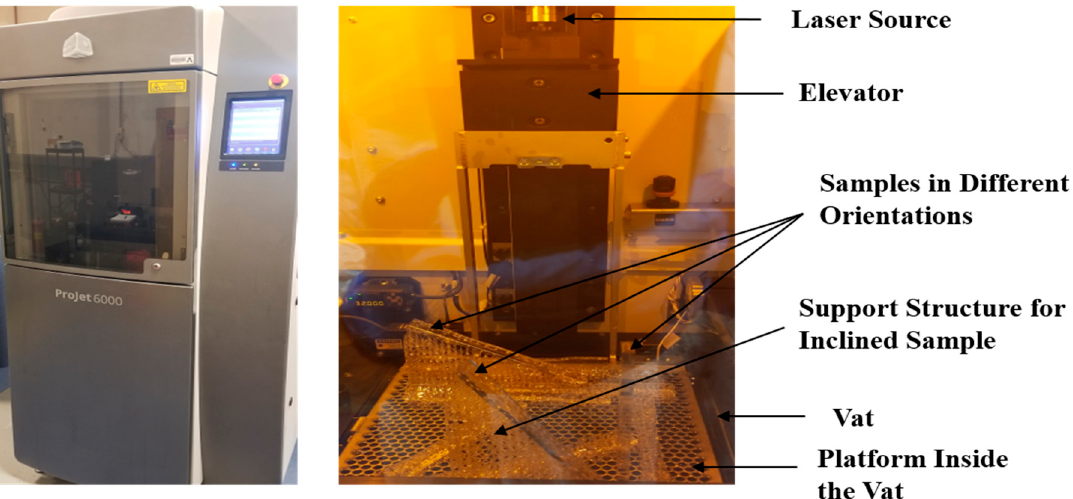
Figure 7. Outer view (left) and Inner view (right), with the printed samples of the used SLA 3D printer, ProJet 6000 HD.